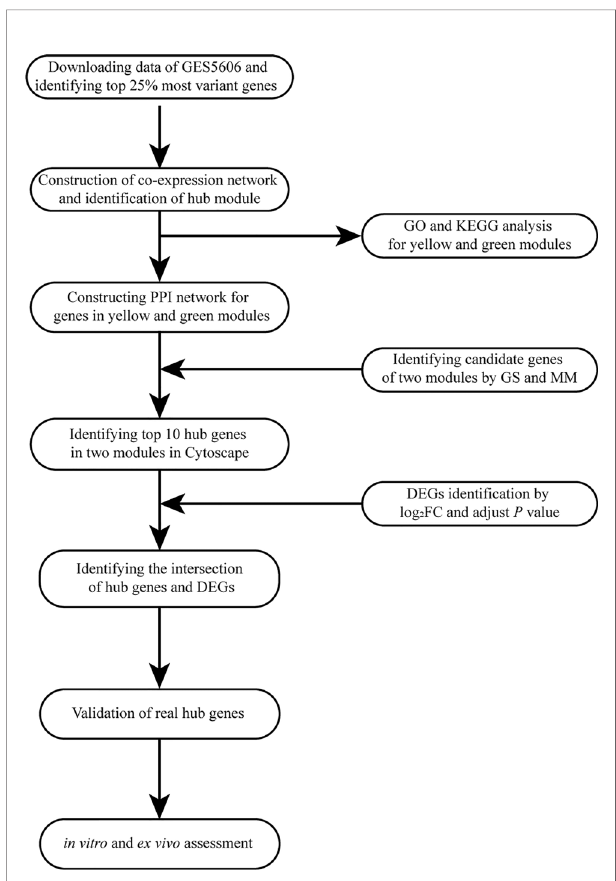
FIGURE 1 | Flow diagram of the analysis procedure: data collection, preprocessing, analysis, and validation. GO, Gene Ontology; KEGG, Kyoto Encyclopedia of Genes and Genomes; PPI, protein-protein interaction; GS, gene signi fi cance; MM, module membership; DEG, differentially expressed gene; FC, fold